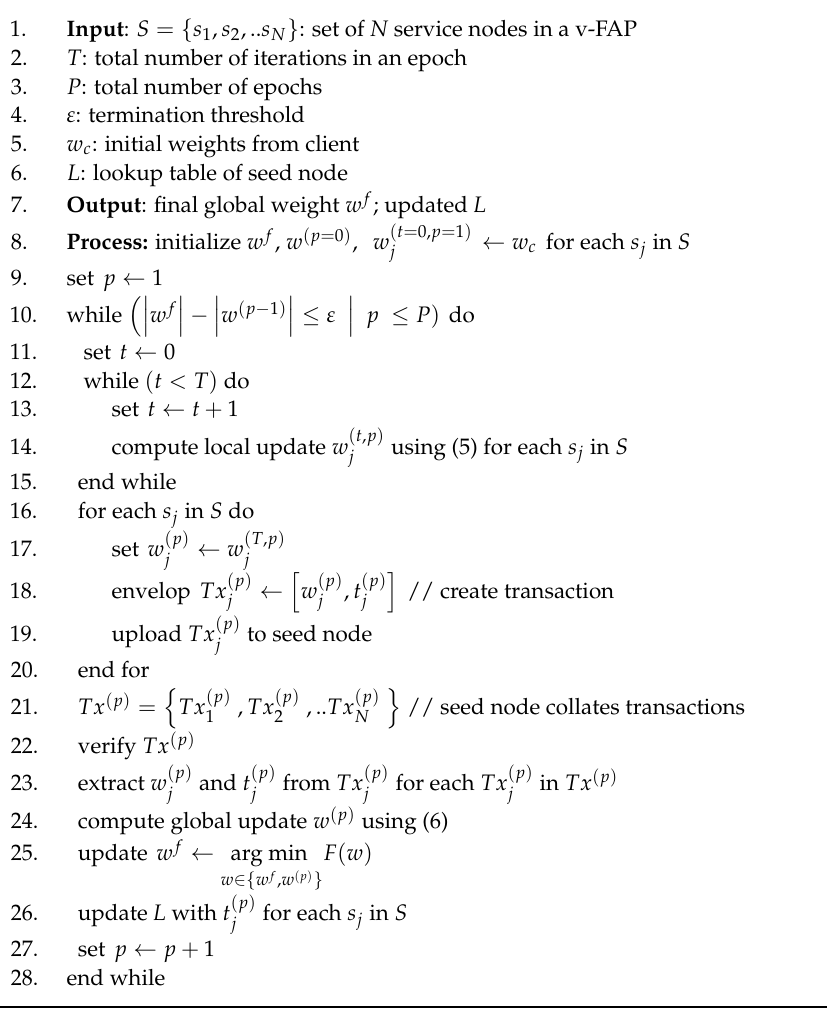
Algorithm 3 : Service Contract for Federated DL